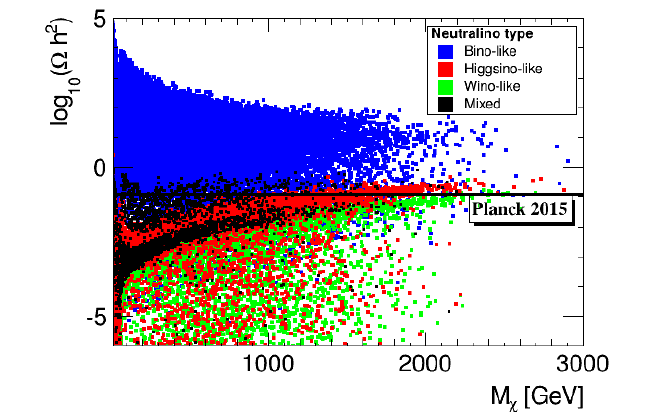
Figure 5 . Neutralino relic density as a function of the neutralino 1 mass, for the di(cid:11)erent neutralino types. The central value of the Planck dark matter density is shown for